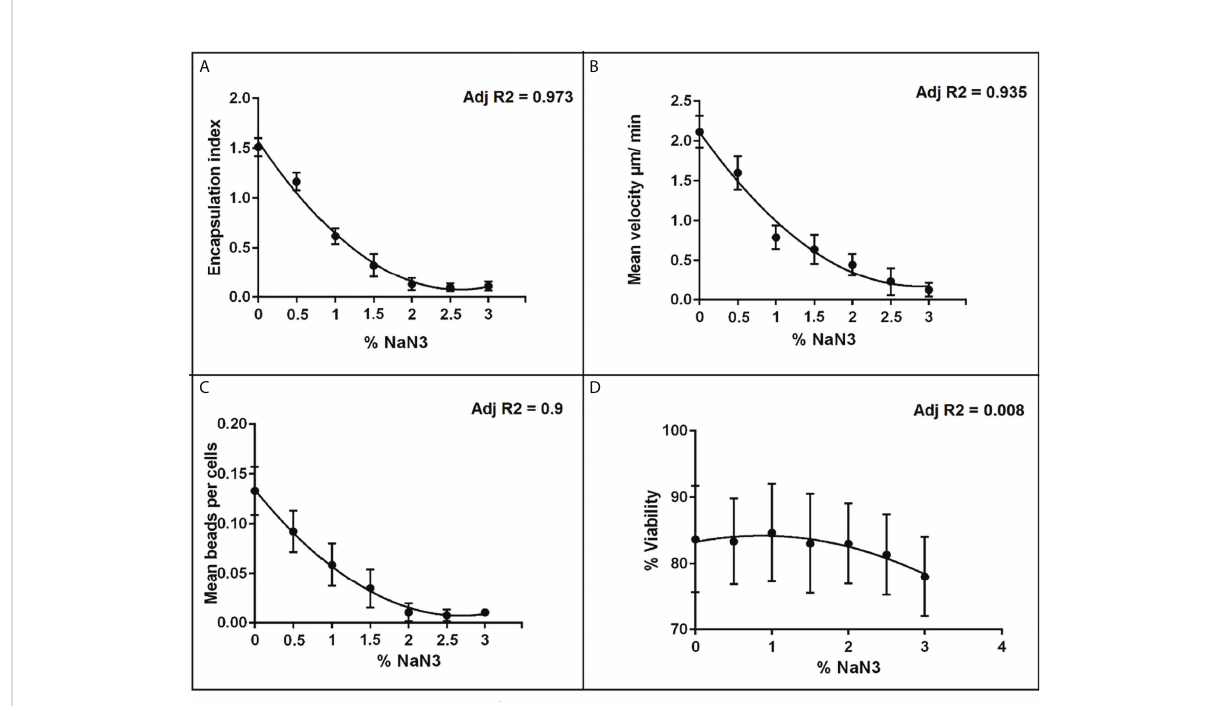
FIGURE 2 Dose-response relationships between the metabolic inhibitor NaN3 and different hemocyte immune endpoints. (A) encapsulation index; (B) mean velocity; (C) phagocytosis and (D) % viability, plotted points represent the SEM of three independent replicates. Adj R 2 is the regression value based on the mean response at each